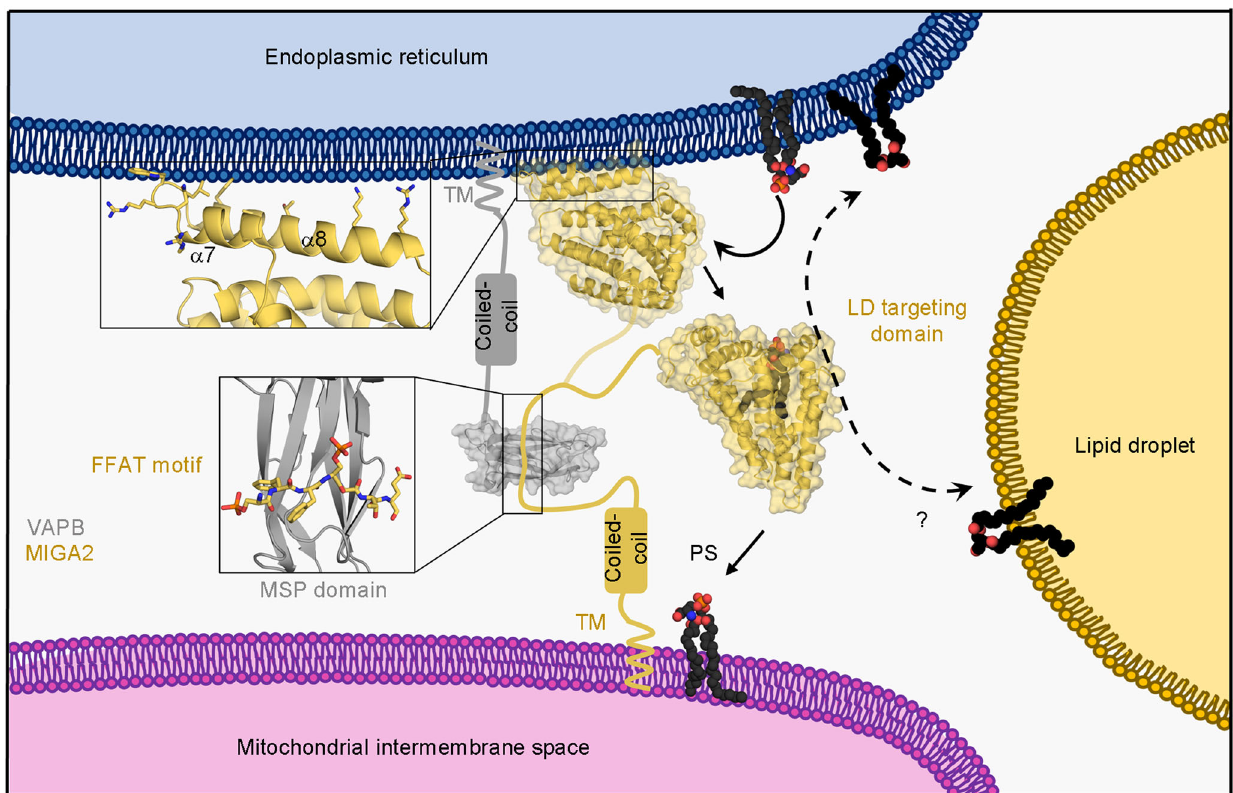
Fig. 7 Putative working model of MIGA2 at the ERMCS. Based on the results of this study, we propose a putative lipid traf fi cking mechanism for MIGA2 between ER (blue), mitochondria (pink), and lipid droplet (yellow) membrane contact sites. MIGA2 (yellow orange) forms a complex with VAPB (gray) via the phosphorylated FFAT motif and then transfers lipids between the membranes by extracting and interiorizing lipids into its large hydrophobic